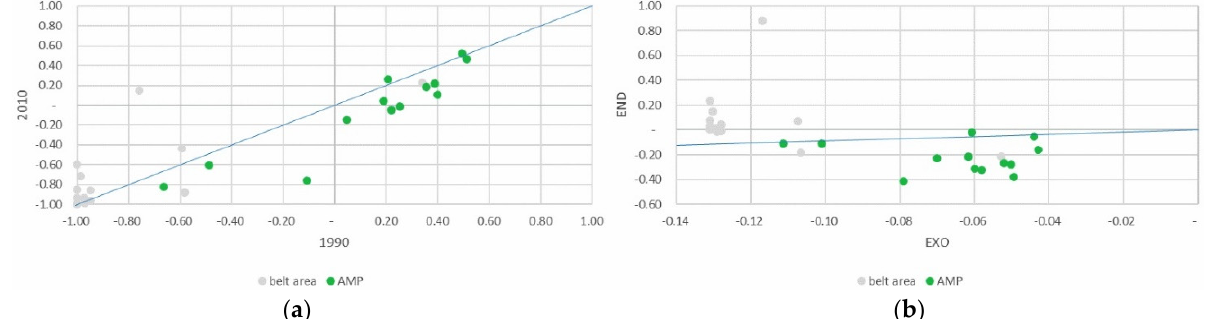
Figure 16. ( a , b ) PSI and DPSI for meadows and pastures. Source: Drawn up by the authors using data provided by the ISTAT.